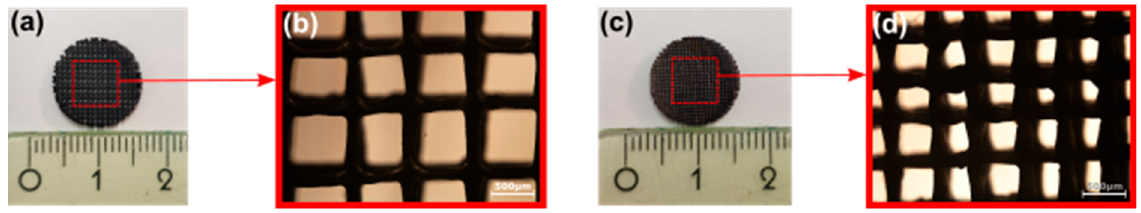
Figure 2. Large ( a ) and small ( c ) pore size SiOC(N) scaffold; the scaffold structure under the optical microscope ( b , d ). The scale bars in ( b , d ) are 500 µm. Table 2. Sample information.